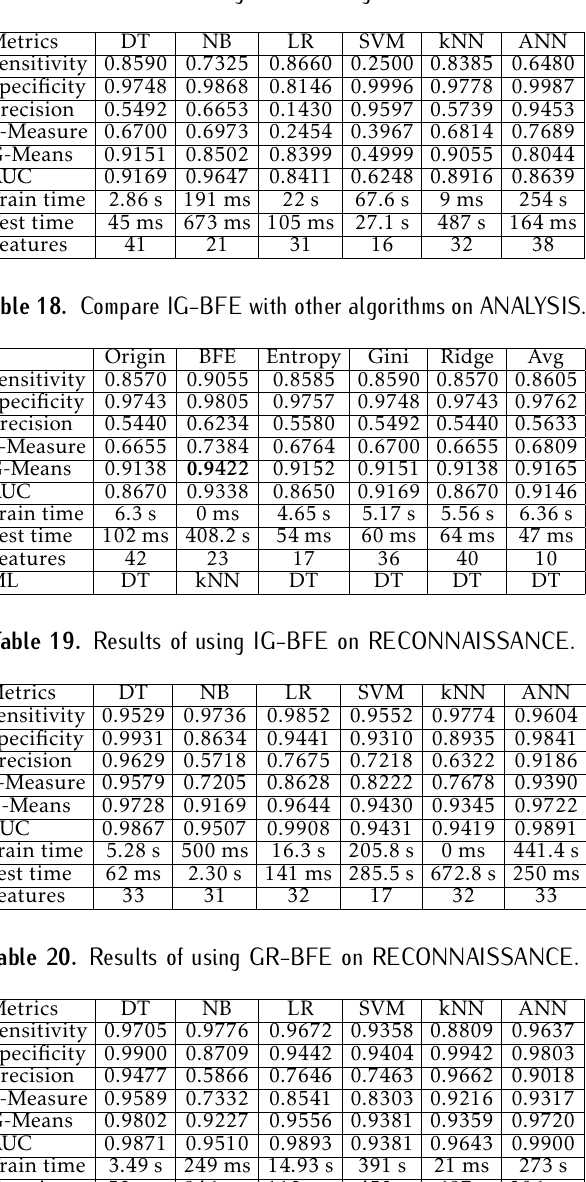
Table 22. Compare CA-BFE with other algorithms on